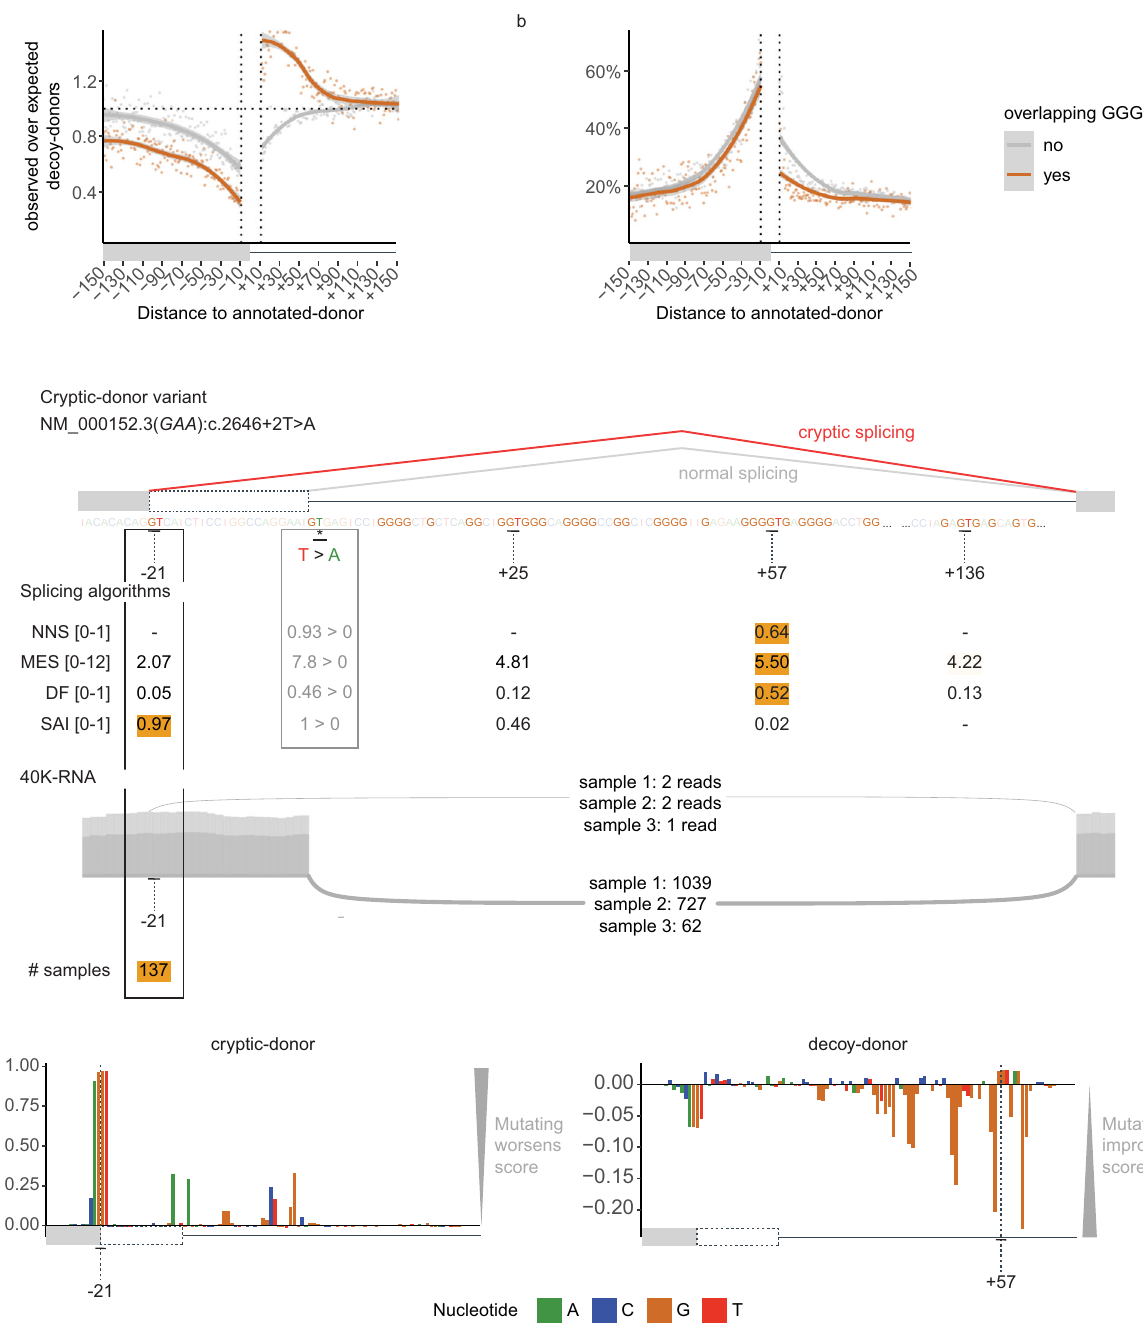
Fig. 5 Utility of 40K-RNA to identify decoy-donors able to be used by the spliceosome. a , b Depletion ( a ) and proportion in 40K-RNA ( b ) of GT decoy- donors that do or do not overlap G-triplets. Calculated as in Fig. 4b, c. Decoy-donors overlapping G-triplets are depleted in the exon but not in the intron, where they show enrichment because: 1) G repeats are enriched in the fi rst 50 nt of the intron (see supplementary Fig. 3) and 2) donor sequences are commonly G-rich. Plots are limited to decoys with relative DF > 0.1 (de fi ned as competitive with the annotated-donor, see Fig. 4d, e). Lines show LOESS smoothing (locally weighted smoothing i.e. trendlines) with con fi dence bands in grey. c Top: Schematic of an AM-variant identi fi ed in an individual with glycogen storage disease type II associated with gene GAA (NM_000152.3:C.2646 + 2 T > A) 23 with algorithm scores for annotated- (REF > VAR) decoy- and cryptic-donors. NNS NNSplice, MES MaxEntScan, DF Donor Frequency, SAI SpliceAI. The strongest donor for each algorithm (score range shown in square brackets) is coloured orange. Below: Sashimi plot from three GTEx RNA-seq samples identifying use of the -21 cryptic-donor as present in 40K-RNA (At least 1 read is detected in 137/30753 samples with detectable expression of transcript). SpliceAI (SAI) correctly scores the − 21 cryptic-donor as the most likely cryptic-donor. d Result of SAI in silico mutagenesis showing the bases contributing to predicted strength of the − 21 cryptic-donor (left) and + 57 decoy-donor (right). SAI score change denotes the decrease (if positive) or increase (if negative) on the predicted strength of the donor when that nucleotide is mutated (see methods). Note that the presence of the cryptic-donor at − 21 and intronic G-repeats negatively impact the score of the + 57 decoy-donor according to